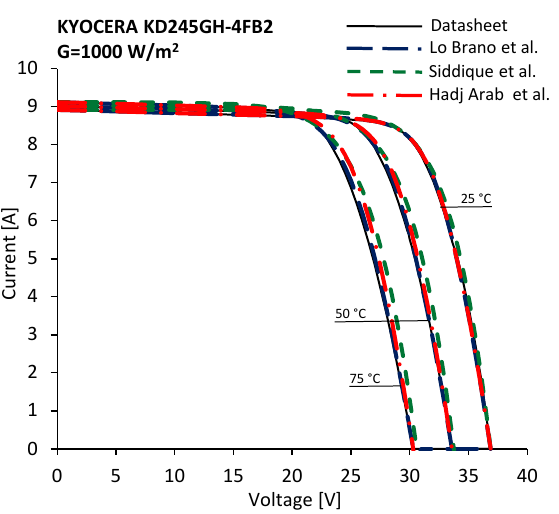
Figure 12. Comparison between the issued I-V characteristics of Kyocera KD245GH-4FB2 at G = 1000 W/m 2 and the characteristics calculated by means of the Lo Brano et al ., the Siddique et al . and the Hadj Arab et al . models.